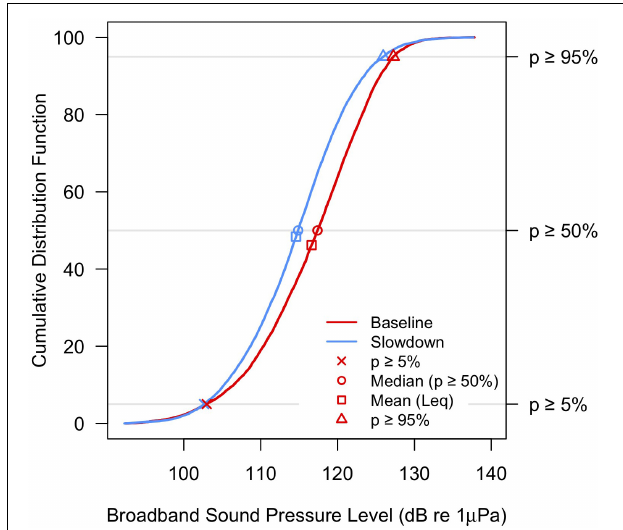
FIGURE 5 | Cumulative Probability Distribution Function integrates the area under the cumulative distribution of 1-min broadband SPL measures (10 Hz to 100 kHz dB re 1 µ Pa) at the Lime Kiln Hydrophone. Red line and symbols represent data collected during the Baseline period; blue line and symbols corresponds to the 61 days Slowdown period. Only minutes with an AIS-enabled vessel within a 6 km detection zone were included. Times with high wind, current, or with small boat noise present were removed. The dB difference at the 5%, 50th%, and 95th percentile of the CDF (p5%, p50%, and p95%) between Baseline and Slowdown periods is provided in Table 6